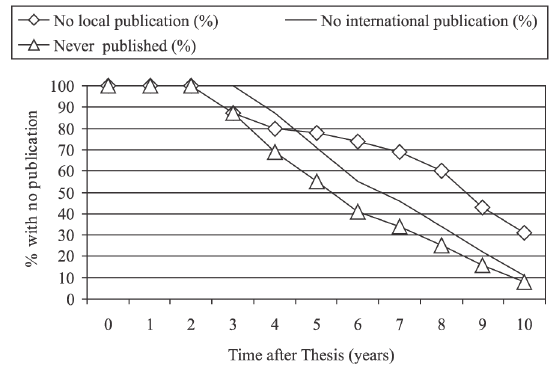
Figure 1 - Percentage of doctorate holders remaining without any publication, either national or international, after the thesis